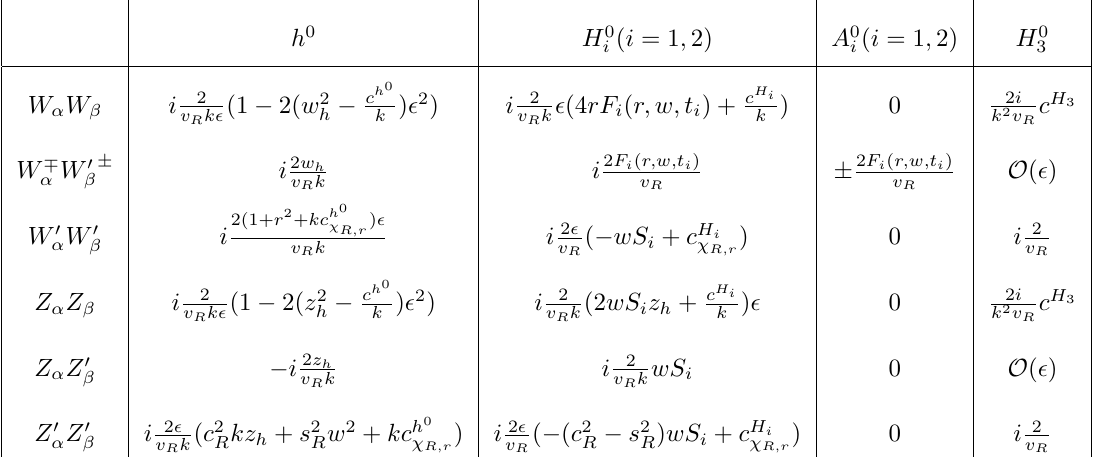
Table 12 . Feynman rules relevant for setting unitarity bounds in the left-right model. All the couplings have to be multiplied by g (cid:11)(cid:12) . Only the LO terms up to O ( (cid:15) ) are shown except for the light Higgs boson where the NLO are also given. The couplings to H 0 not given explicitly. The results are given in units of the masses of the two interacting gauge boson given in the (cid:12)rst column.